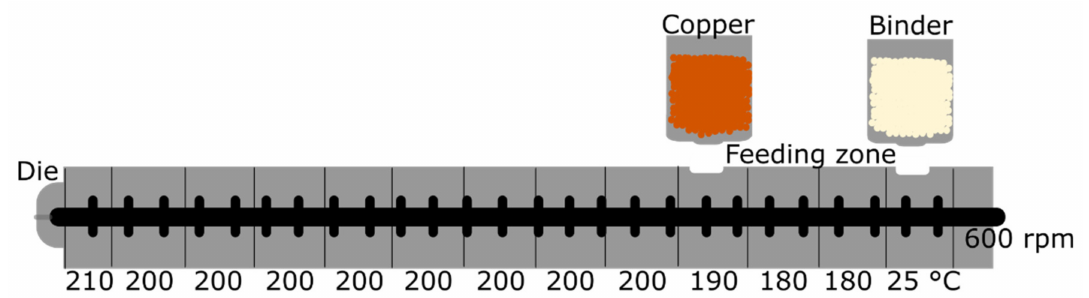
Figure 2. Temperature profile of compounder used to prepare copper